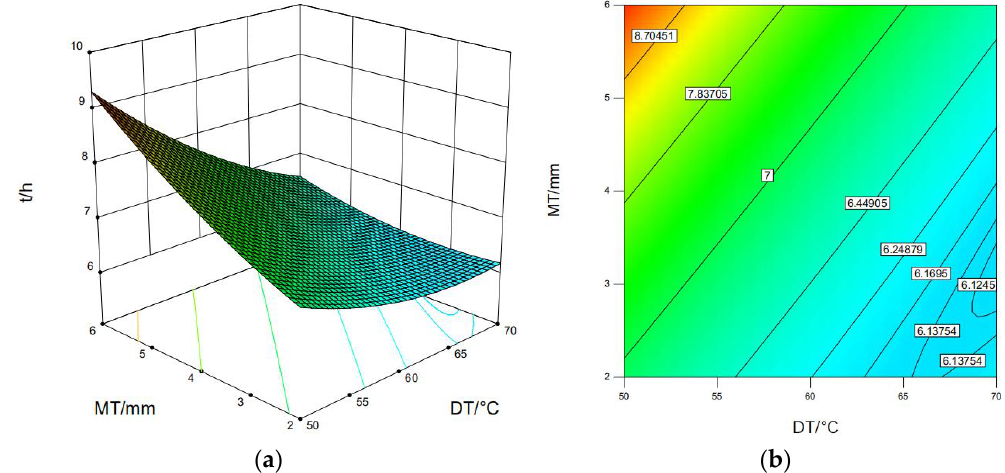
Figure 3. Response surface ( a ) and contour ( b ) for drying time with respect to interaction term DT•MT at a constant vacuum degree of 0.06